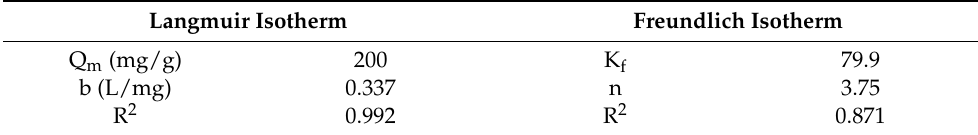
Table 3. Comparison of various adsorbents with hydroxyapatite for the removal of the dyes from aqueous media.